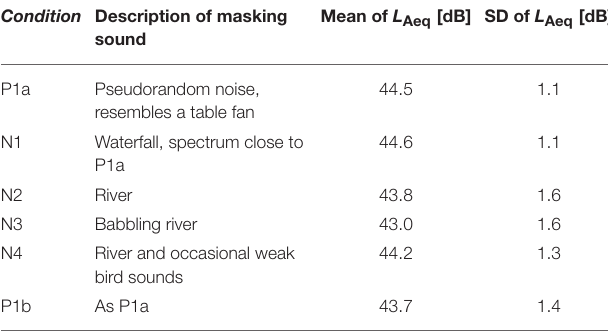
TABLE 1 | The descriptions of the sound conditions and the mean and the standard deviation (SD) of equivalent A-weighted sound pressure level, L Aeq,15s , based on measurements in 54